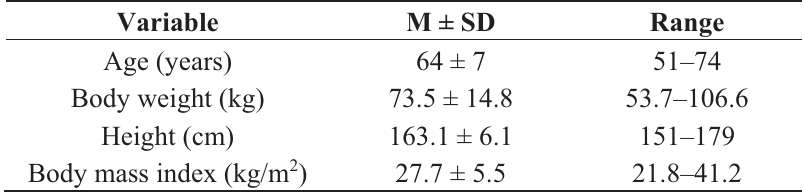
Table 1. Participant Characteristics ( N = 27).